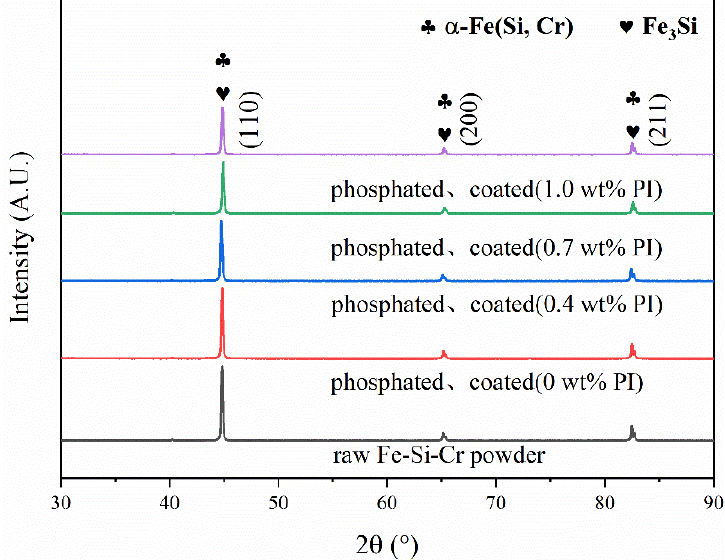
Figure 8. XRD patterns of Fe-Si-Cr powders with different PI coating contents.